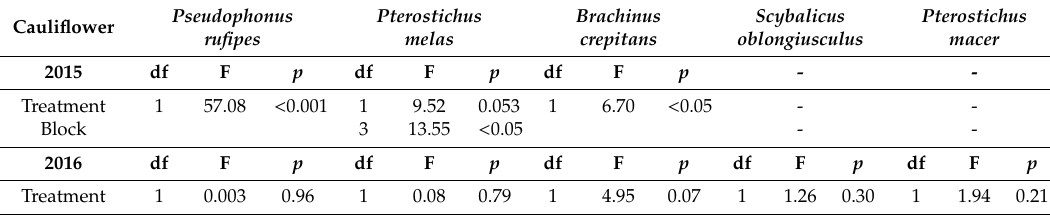
Figure 2. Mean number of individuals caught per trap per week of the dominant species of Carabidae and Staphylinidae collected in the experimental plots of cauliflower, where the cover crops were terminated either with a roller crimper (IL-RC, dark grey bars) or through green manuring (GM, white bars). Lines represent the standard errors of the means; * = significant differences for each species as detected by ANOVA . Table 2. Results of ANOVA carried out on the most abundant species of Carabidae (pooling all the individuals caught in each plot over the whole sampling period) in cauliflower plots. Blocks were omitted if their effect was not significant.